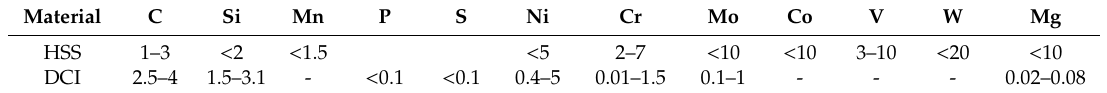
Table 1. Chemical composition of the high speed steel (HSS) work roll, wt%.